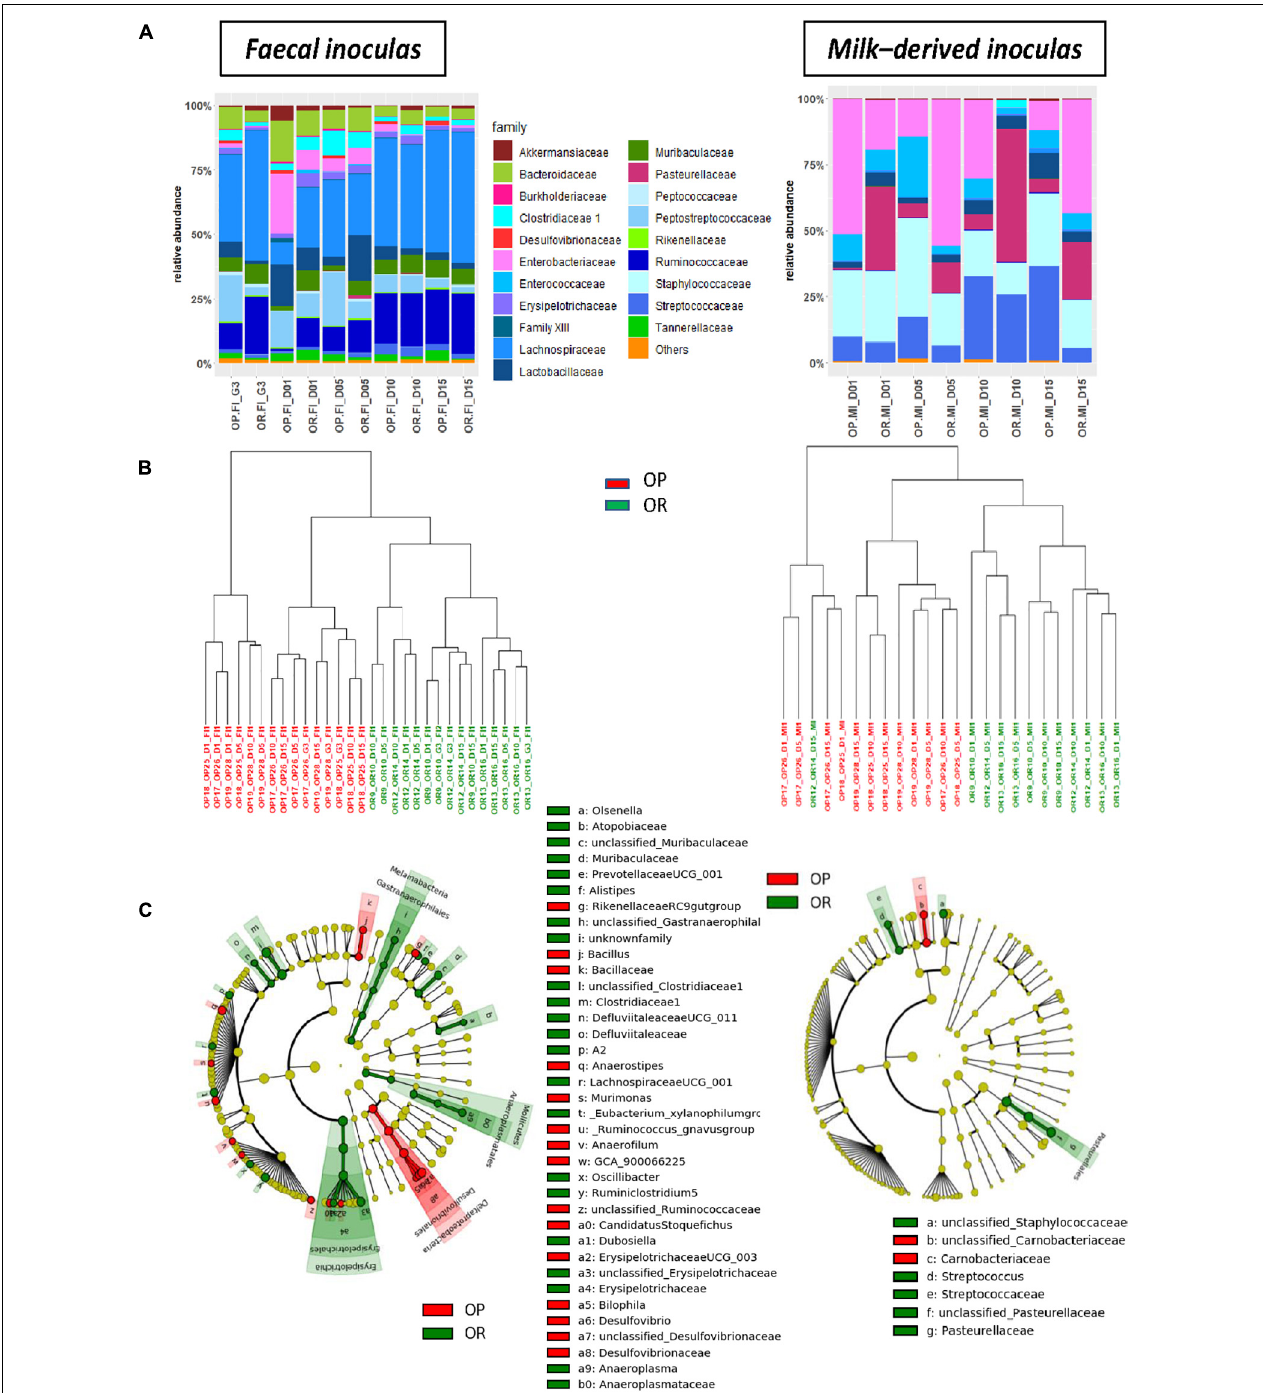
FIGURE 2 | Bacterial composition and structure of inocula prepared from OP and OR dams ( n = 3 per genetic origin and sampling time). (A) Relative abundances of bacterial family and (B) Cluster dendrograms of dissimilarities measures (Cao) in inocula according to sampling time (OP-inocula are in red and OR-inocula are in green). (C) Taxonomic cladograms obtained from LEfse analysis of OTU abundances, showing as circles (which diameters are proportional to abundances), taxa that significantly ( p < 0.01) discriminate inocula according to their genetic origins, on concentric rings from domain in the innermost one to genera in the outermost (see Supplementary Figure 1 for LDA